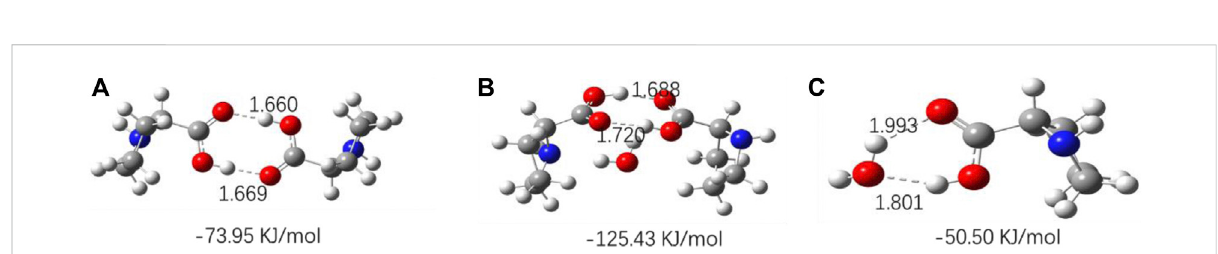
FIGURE 10 Optimized geometries for the amino acid complexes. (A) DL -Proline (dimer); (B) DL -proline + H 2 O complexes; and (C) DL -proline – H 2 O complexes; hydrogen bonds are denoted by dashed lines, and the corresponding H ··· O and N ··· H distances are labeled. The interaction energy of each complex is noted below the structure.